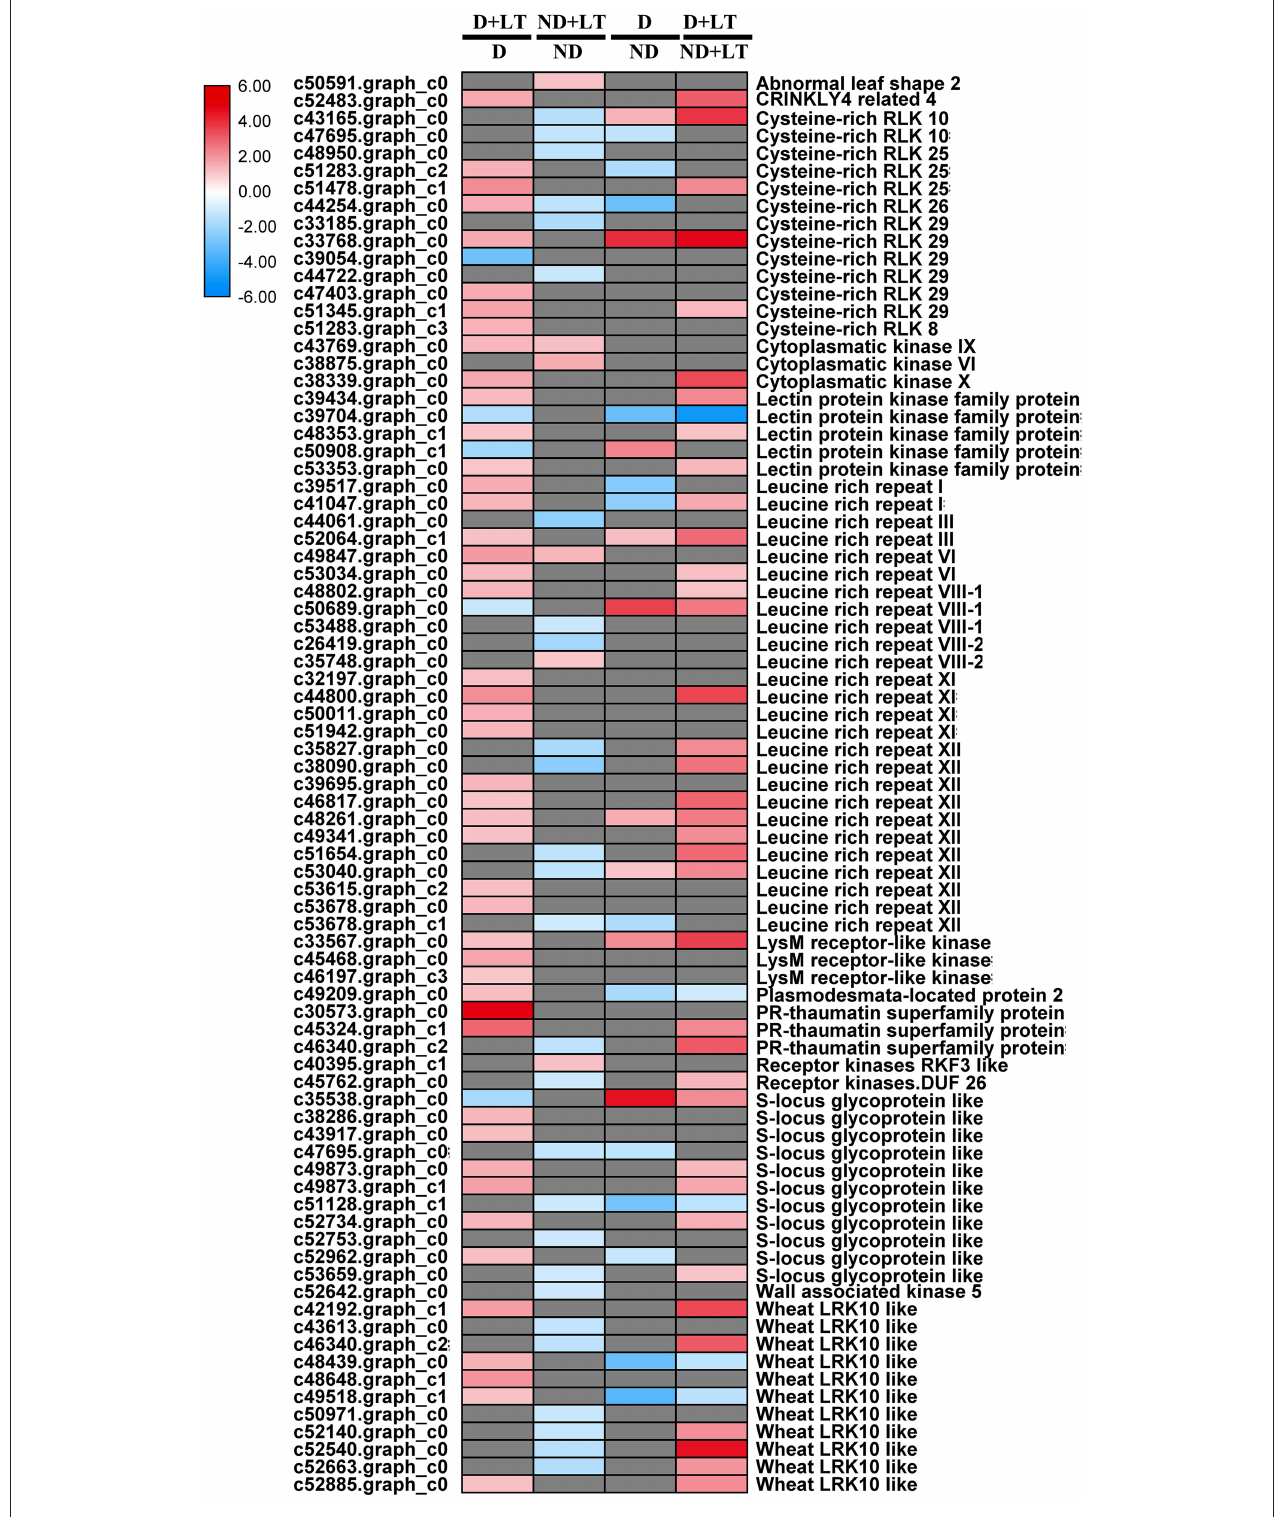
FIGURE 4 | Transcript profiles of receptor kinase signaling in different dormancy varieties of alfalfa under LT. The color scale indicates log 2 -transformed fold changes in expression levels between dormancy (D) and non-dormancy (ND) genotype under normal growth conditions or LT conditions. Red, blue, and gray denote upregulation, downregulation, and no change in expression,